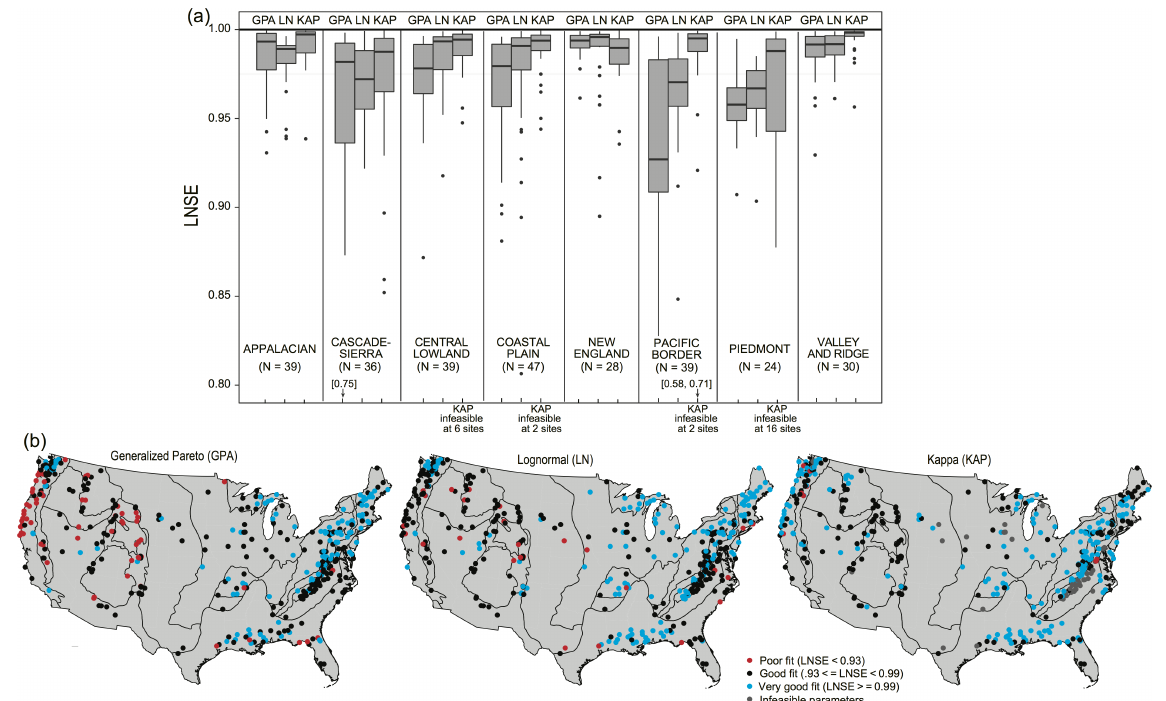
Figure 5. (a) By physiographic region, boxplots of streamgage Nash–Sutcliffe efficiencies of natural logarithms of daily streamflows (LNSE) based on hypothesized generalized Pareto (GPA), lognormal (LN), and kappa (KAP) distributions with points outside the bounds of the plots listed in brackets. Below the region name, the number of study gages located in that region is listed as N . Boxplots are only given for regions with at least 20 study gages to facilitate a relatively fair comparison across regions. (b) Maps of the conterminous United States illustrating streamgage LNSE values for the GPA, LN, and KAP